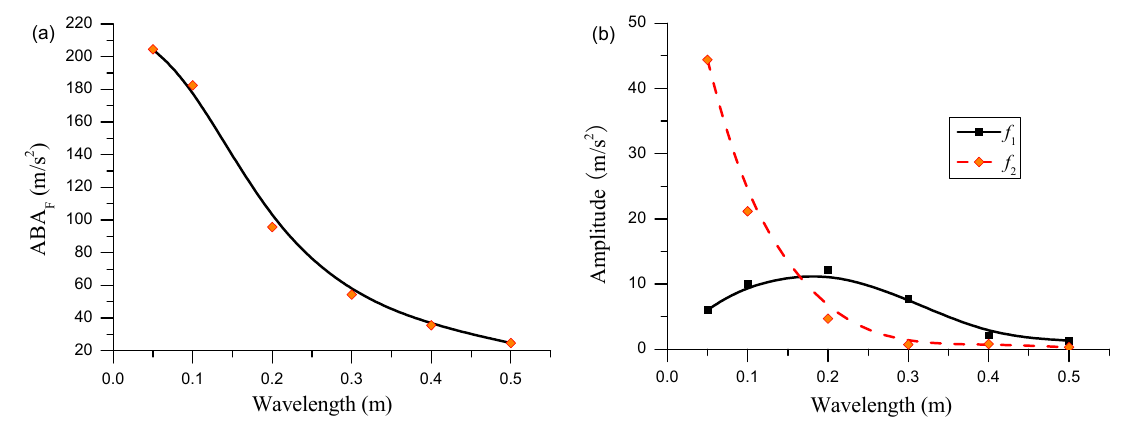
Figure 11. The influence of wavelength on ( a ) ABA and ( b ) variation of amplitude at f 1 and f 2 .